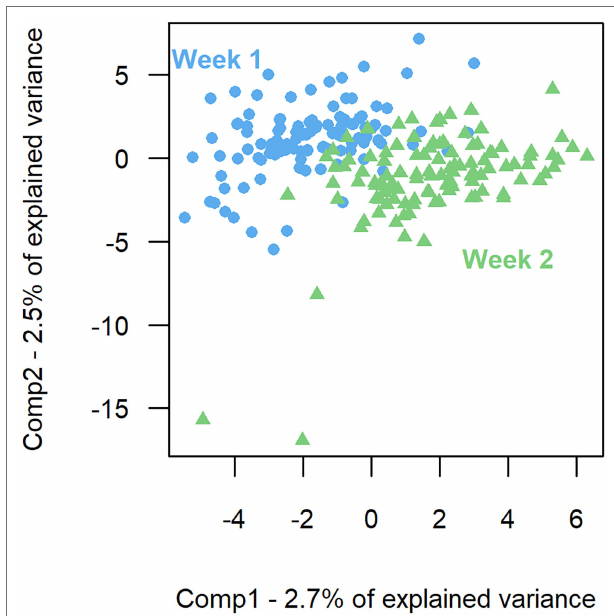
FIGURE 2 | Sparse partial least square discriminant analysis of the rumen bacterial composition between the 2 weeks of sampling. First component (Comp1) plotted against second component (Comp2) presenting the largest explained variance between weeks.